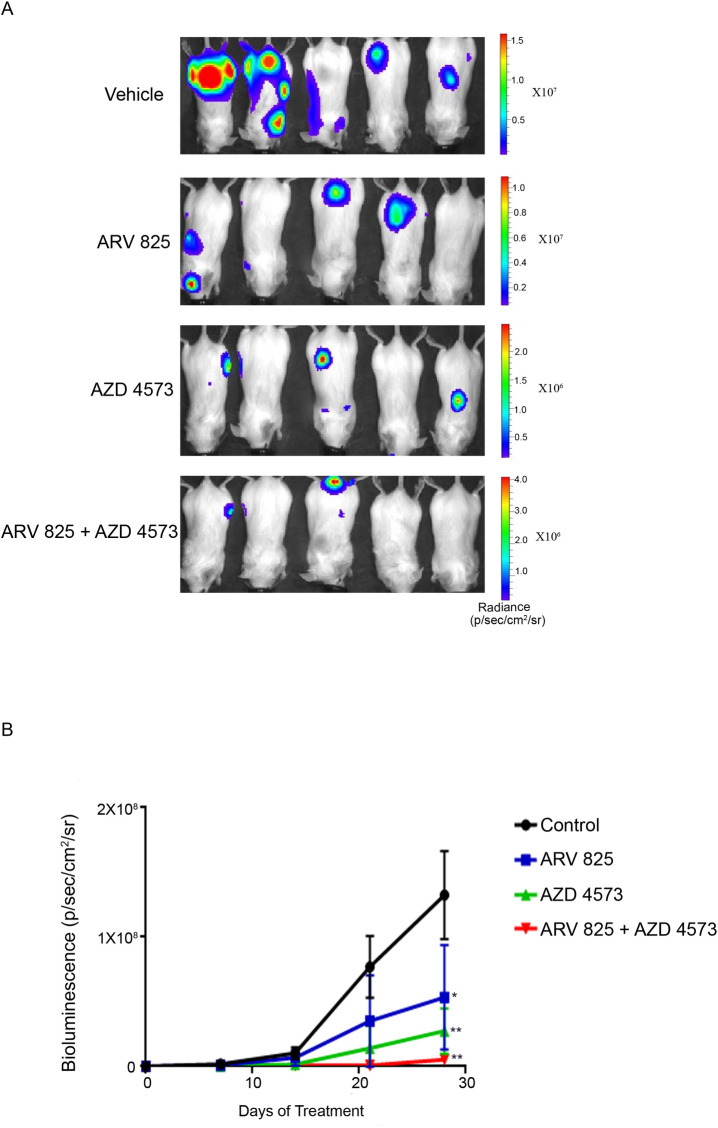
AZD 4573 acts synergistically with ARV 825 in inhibiting MM cells in vivo.(A) Whole-body bioluminescence images of SCID-beige mice after intravenous injection with KMS11LUC cells followed 7 days later by treatment with either ARV 825 (5 mg/kg IP daily for 28 days) or AZD 4573 (10 mg/kg, IP, twice a day with 2 h interval for two consecutive days/week for 4 weeks) as well as a combination of both drugs and vehicle control alone. (B) Tumor burden as measured by bioluminescence in SCID-beige mice after intravenous injection with KMS11LUC cells. Data represent mean ± SD (N = 5 per group). *p ≤ 0.01, **p ≤ 0.001, ***p ≤ 0.0001.